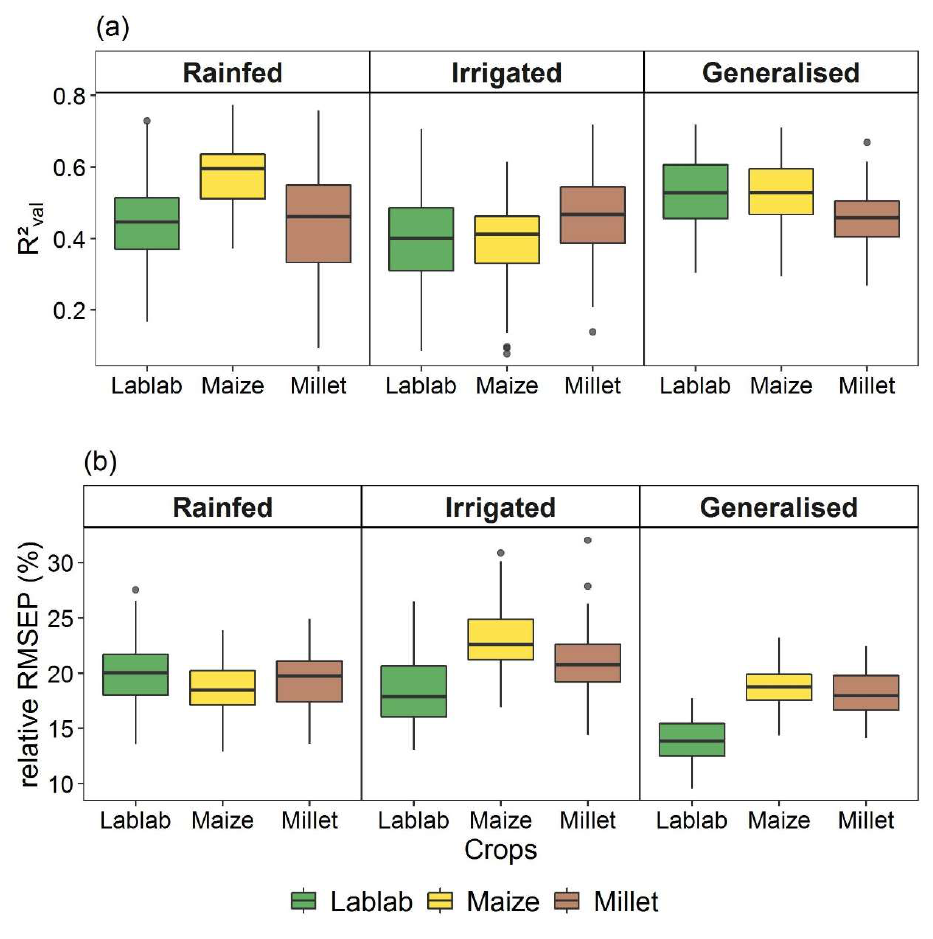
Figure 5. Prediction accuracy measured as R² val ( a ) and rRMSEP ( b ) values of the models (Rainfed, Irrigated and Generalised) for fresh matter biomass of lablab, maize and finger millet. Models were built on data from three different years, three levels of N and two levels of water supply (i.e., rainfed and irrigated).